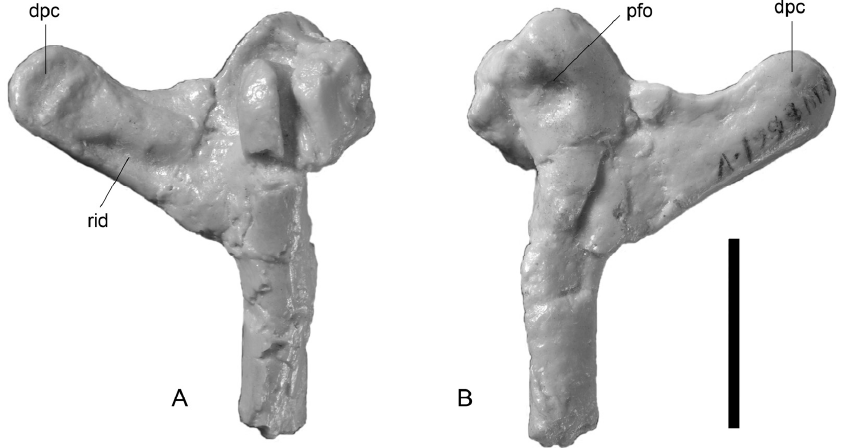
Fig. 2 – Specimen MB.R. 2828 in: A. medial view, B. lateral view; dpc – deltopectoral crest; pfo – pneumatic foramen; rid – ridge (scale 2 cm).